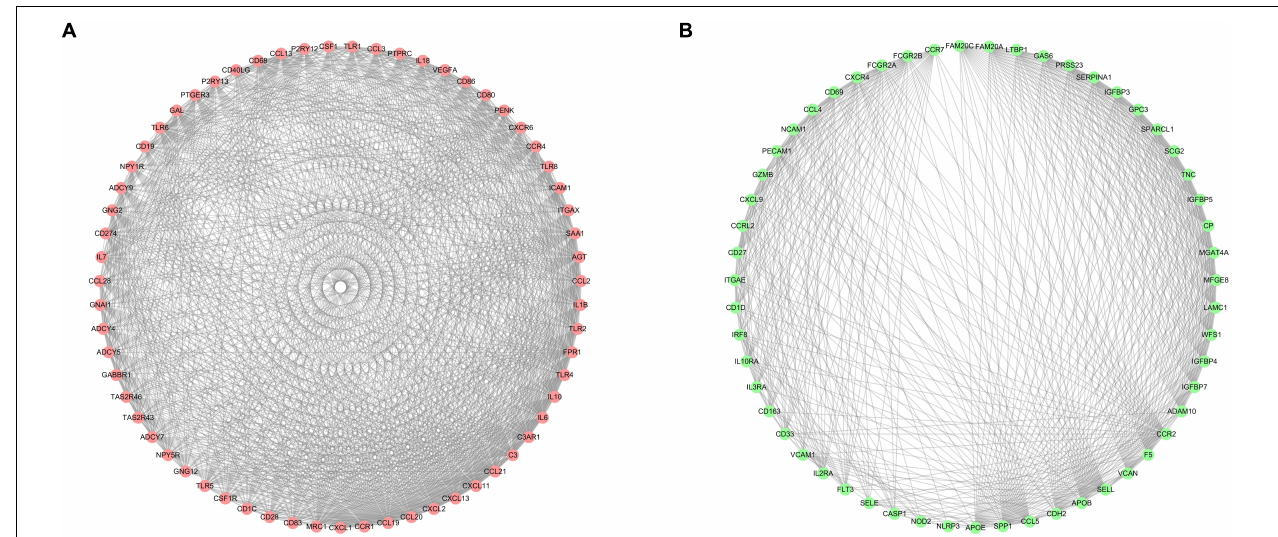
FIGURE 7 | Identification of the top two sub networks by using the MCODE algorithm. (A) The first sub network. (B) The second sub network.